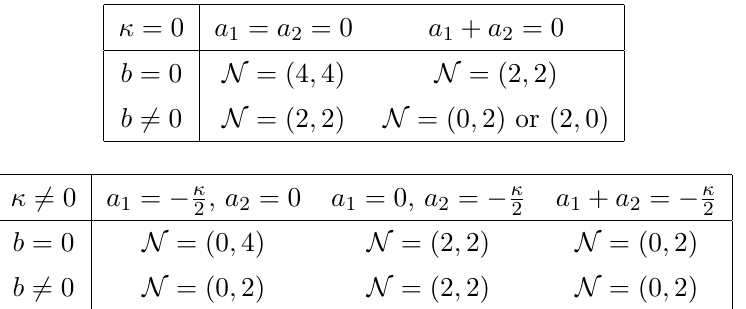
Table 5 . Classi(cid:12)cation of topologically twisted 4d N = 2 SCFTs on Riemann surfaces of constant curvature (cid:20) = (cid:6) 1 ; 0 in terms of the surviving amount of supersymmetry in 2d. We include the possibility of a twist along the (cid:13)avor symmetries, with (cid:13)ux b